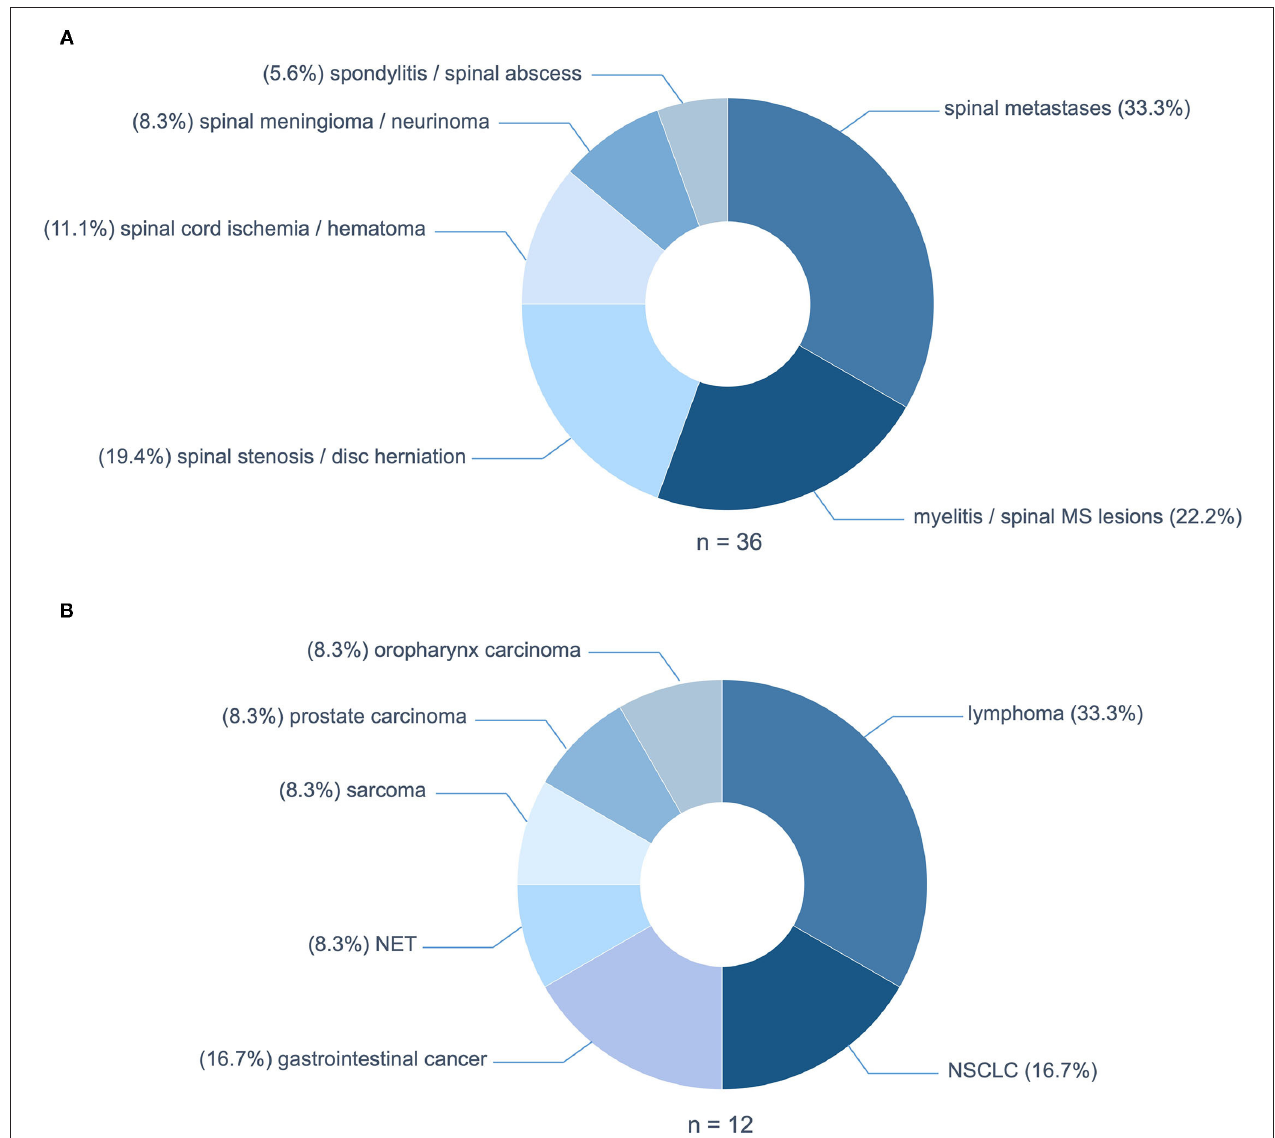
FIGURE 2 | (A) Etiologies of non-traumatic spinal cord injury (NTSCI). (B) Underlying tumor entities of spinal metastases. MS, multiple sclerosis; NSCLC, non-small cell lung cancer; NET, neuroendocrine tumor.